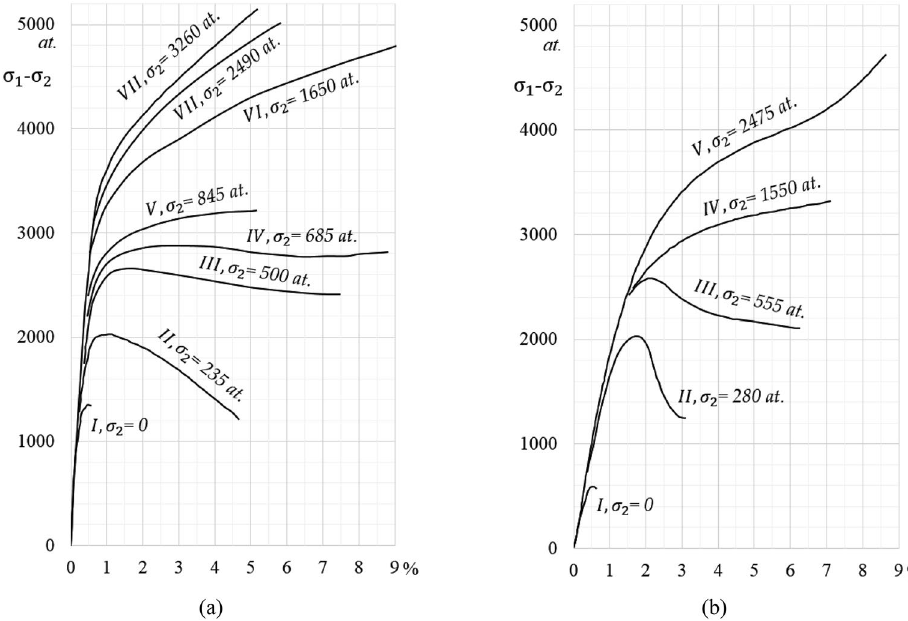
Figure 1. Typical stress–strain curves of ( a ) Carrara marble and ( b ) Mutenberg sandstone in case of different confining pressures (1 atm = 0.101325 MPa) 20,25 .